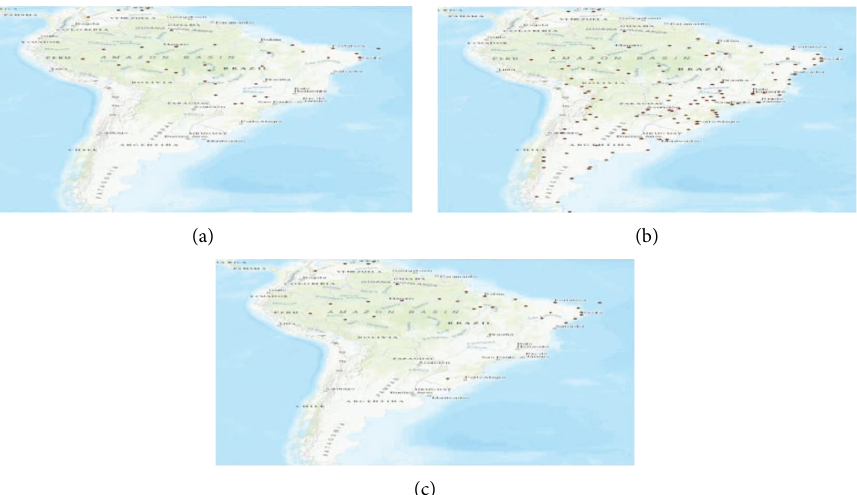
Figure 11: LCC of the South America component after isolation from the network. Te brown dots represent the remaining airports after attacks on the world air transportation network (a) strength attack, (b) weighted betweenness attack, and (c) weighted PageRank attack. Te LCC isolated by the strength and weighted PageRank attacks includes Brazil and Venezuela. Te LCC separated by the weighted be- tweenness attack covers all the initial component regions.